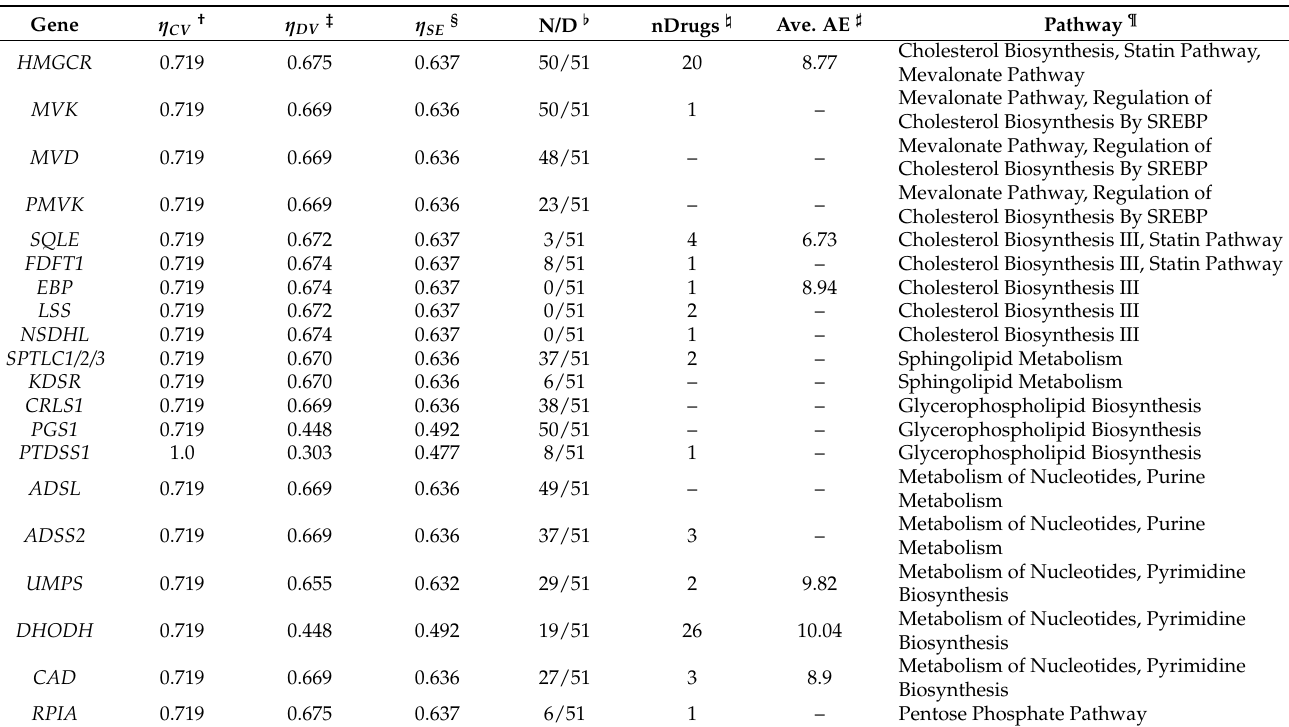
Table 2. Top 20 one-target genes obtained using the IACT framework. SPTLC1/2/3 is a complex of serine palmitoyltransferase constructed by SPTLC1 , SPTLC2 , and SPTLC3 . Other genes each encode for a single enzyme, as shown in the abbreviations section. The symbol (–) denotes that data are